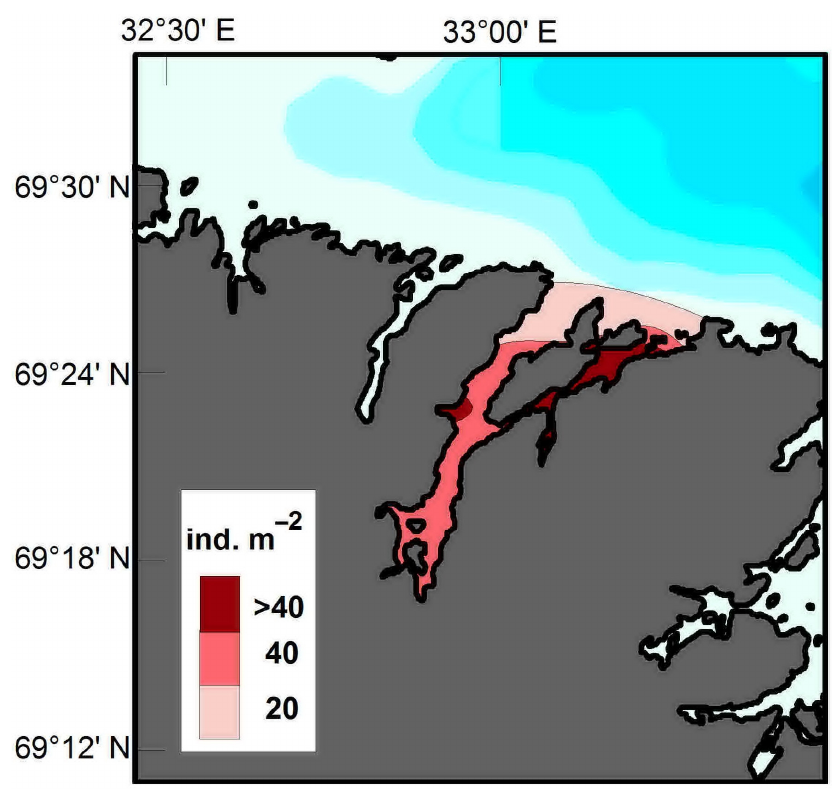
Figure 4. Distribution and abundance (individuals m −2 ) of red king crab larvae in Russian waters of the Barents Sea (spring 1996–1999, Ura Bay) (modified from [79]). The maximum density of the larvae was 198 ind. m −2 . In the central part of the bay, the larval density tended to be lower than 40 ind. m 2 and the same values were recorded in the outer part. The inshore waters adjacent to Ura Bay had a low abundance of RKC zoeae (<20 ind. m –2 ) [79]. The average density of RKC larvae was 40.4 ind. m –2 in 1996 and a 4-fold decrease was registered in 1998 (10.2 ind. m –2 ) and 1999 (12.4 ind. m –2 ) [79]. The authors concluded that aggregations of RKC larvae in Ura Bay were present at sites with low water exchange [79]. Similar patterns have been documented for other small bays and inlets of the Kola Peninsula with local eddies preventing the dispersal of RKC larvae to offshore waters [68,79]. The first RKC larvae appeared in the plankton of Ura Bay in early March [79] as zoea I, while zoeae II appeared in late March. Zoeae III began to occur in April. The highest density of RKC larvae was reported in late April–early May, i.e., during the period of seasonal zooplankton maximum (Table S1). The maximum density of zoeae I–IV ranged from 50 to 198 ind. m –2 with zoeae II–III being the most numerous (Table S2). The total larval density decreased to 10–40 ind m –2 by late May. In June, zoeae accounted for 4–28 ind. m –2 and the bulk of larvae were present as zoea IV (95%). Subsequent development of zoea IV into glaucotoe, a postlarval stage, and settlement were reported in late June [79]. The dynamics of zoeal size in Ura Bay is shown in Figure 5. There was a clear in- crease in the total body size from earlier to late stages (Figure 5) [79].